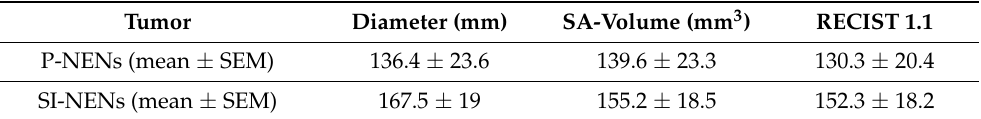
Table 5. Accumulated absorbed dose (Gy) from baseline to best response in regard to diameter, semi-automated (SA) volume and RECIST 1.1.